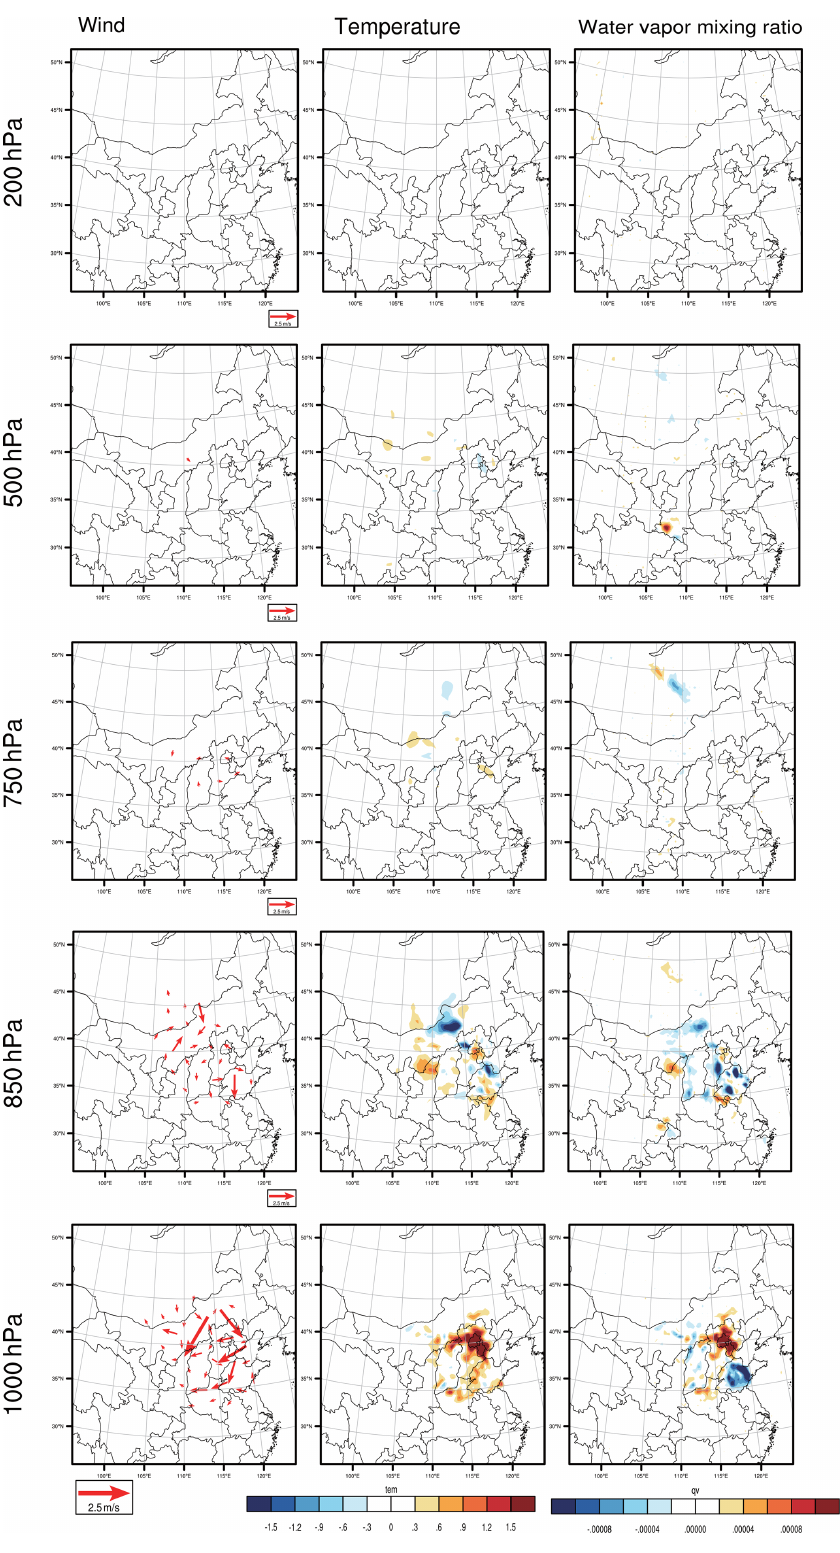
Figure 4. The same as in Fig. 3 but for the forecast starting from 14:00BJT on 1 December, with a lead time of 12h.